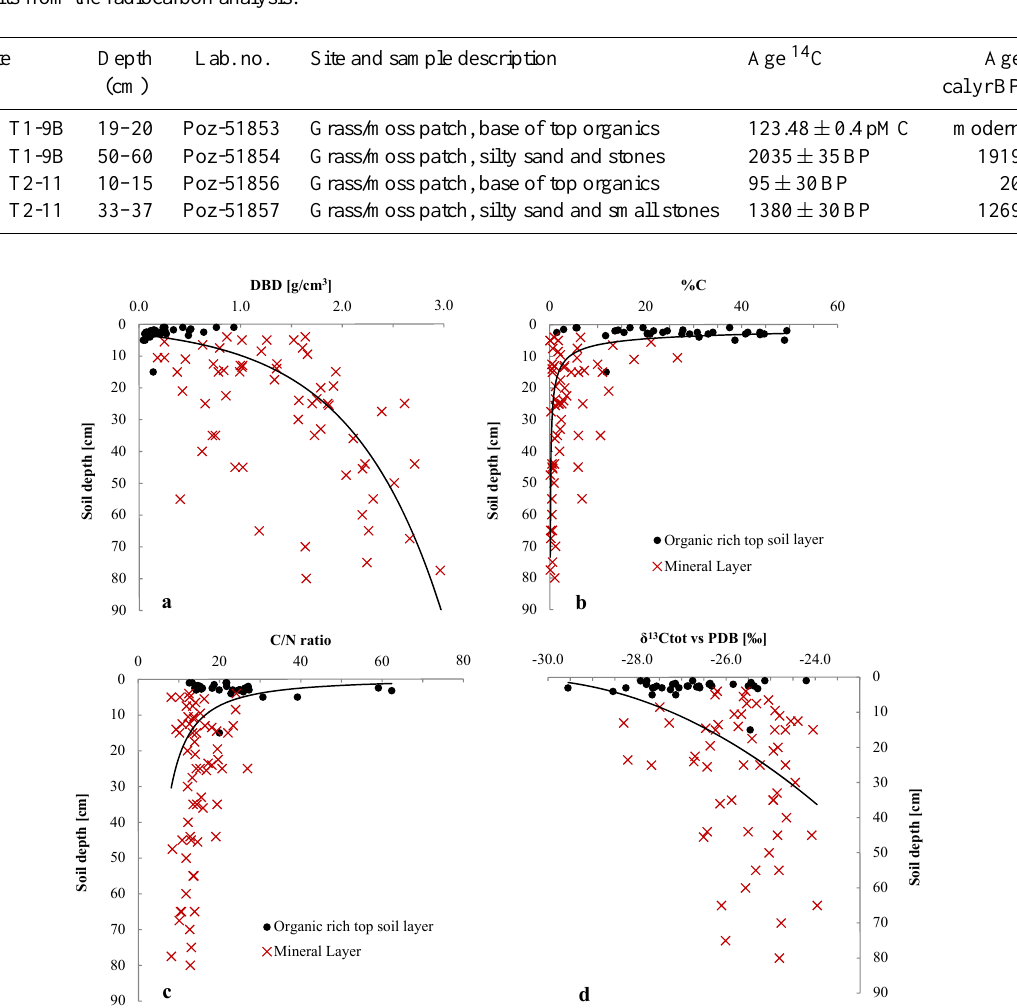
Figure 3. Results of the geochemical analyses of the soils samples of Tarfala Valley. DBD is Dry bulk density (a) ; %C is percentage C (b) ; C / N is the weight ratio (c) ; δ 13 C tot vs. PDB is the stable isotope δ 13 C analyzed to the international standard PeeDeeBelemnite (d) . Lines are best-fit power, polynomial or exponential regressions, shown for graphic representation of mean trends only. Some high bulk density values (up to 3.0gcm − 3 ) in sandy profile sites are probably the result of errors in field volume estimates due to difficulties in collecting these loose